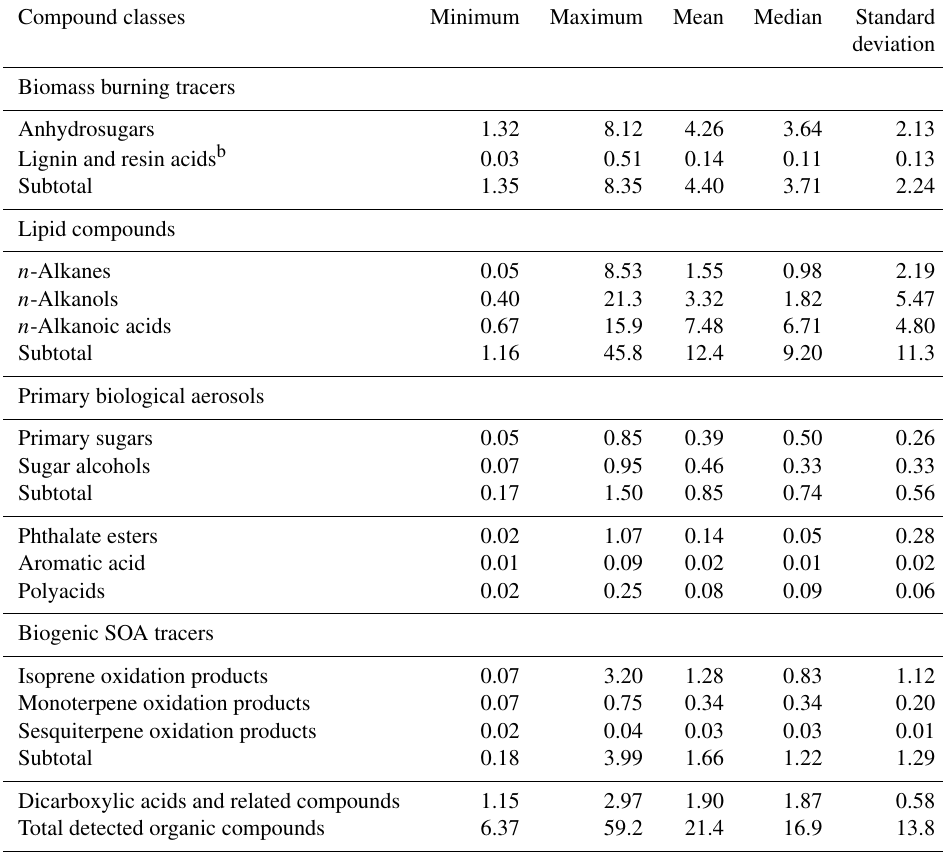
Table 3. Contributions (%) of individual organic compound classes to organic carbon (OC) in PM 2 . 5 aerosols from central Alaska a . Compound